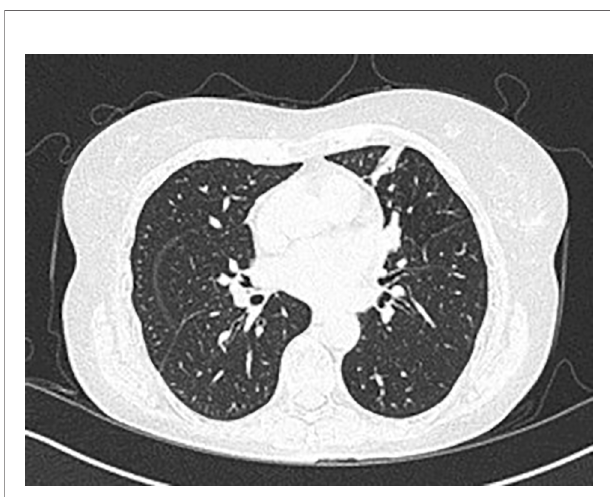
FIGURE 2 | Chest CT scan image showing segmental aerated collapse of the